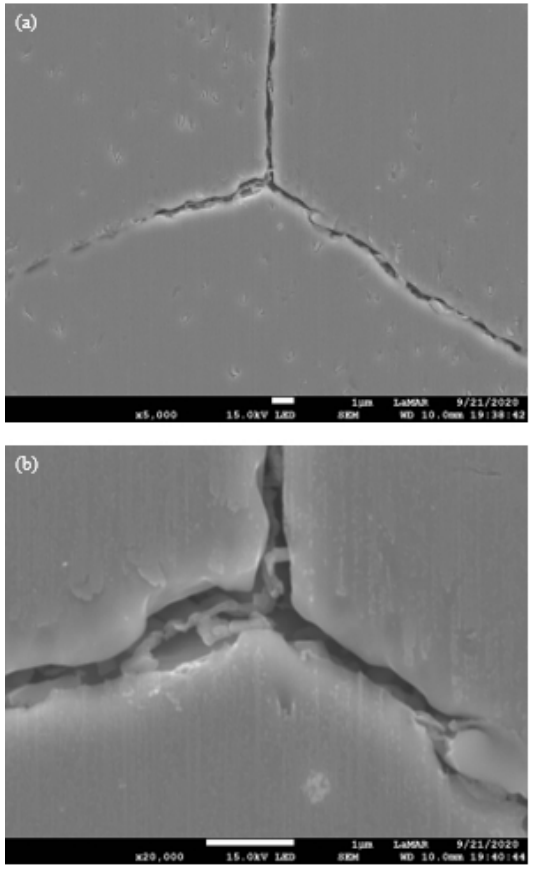
Figure 9. Discontinuous intergranular precipitates aging for 2000 h. Image obtained in SEM with (a) 5000X and (b) 20000X in secondary electron (SE) mode.